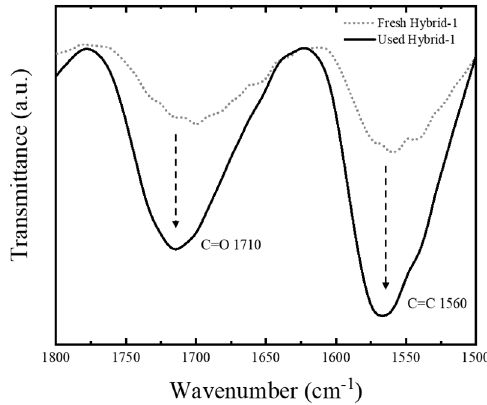
Figure 4. Gas chromatography graph ( a ) before and ( b ) after photodegradation under 254 nm UVC irradiation for 30 min. (The inset in ( a ) is the mass spectrum of 2-butanone, and the inset in ( b ) is the mass spectra of H 2 O and air), ( c ) photodegradation of 2-butanone under 254 nm UVC irradiation with di ff erent catalysts such as TiO 2 -P25, Ga 2 O 3 and Ga 2 O 3 -rGO hybrids. TVOC refers to the total volatile organic compounds and a group of a wide range of organic chemical compounds. The guideline below 0.3 mg / m 3 provides practical guidance to manage health and safety risks, which are regulated under Health and Safety, and subject to change (inset: Schematic drawing of the photocatalytic reactor), and ( d ) repeatability test of photocatalytic degradation of Hybrid-1 under 254 nm UVC irradiation at intervals of 15 min.